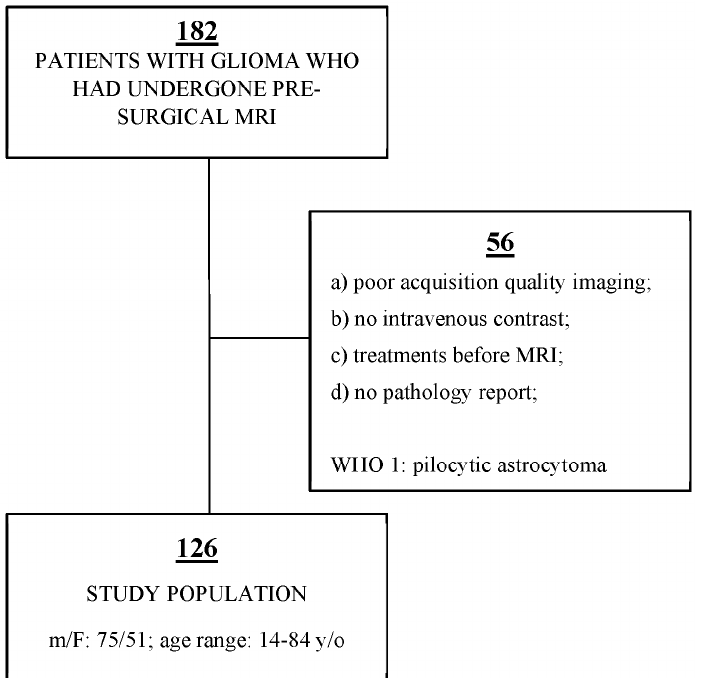
Figure 1. Sample size selected strictly by exclusion criteria (We retrospectively reviewed our institution’s database, identifying 182 patients. We excluded 56 patients due to exclusion criteria. Finally, 126 patients were enrolled in our study. The flowchart shown in the figure also indicates the sex, the age range and the exclusion